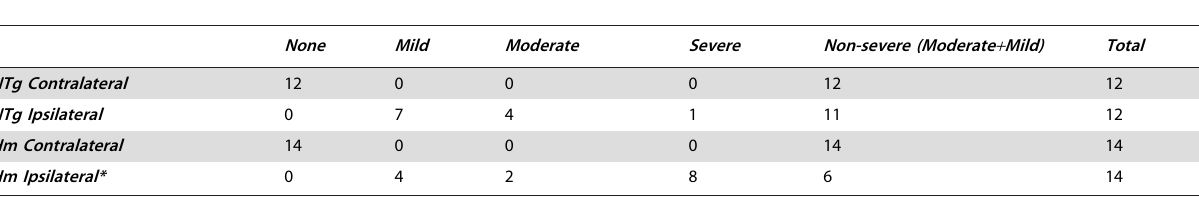
Table 1. Severity of the presence of pyknotic nuclei in cells in ganglion cell layer (GCL) after transient inner retinal ischemia.